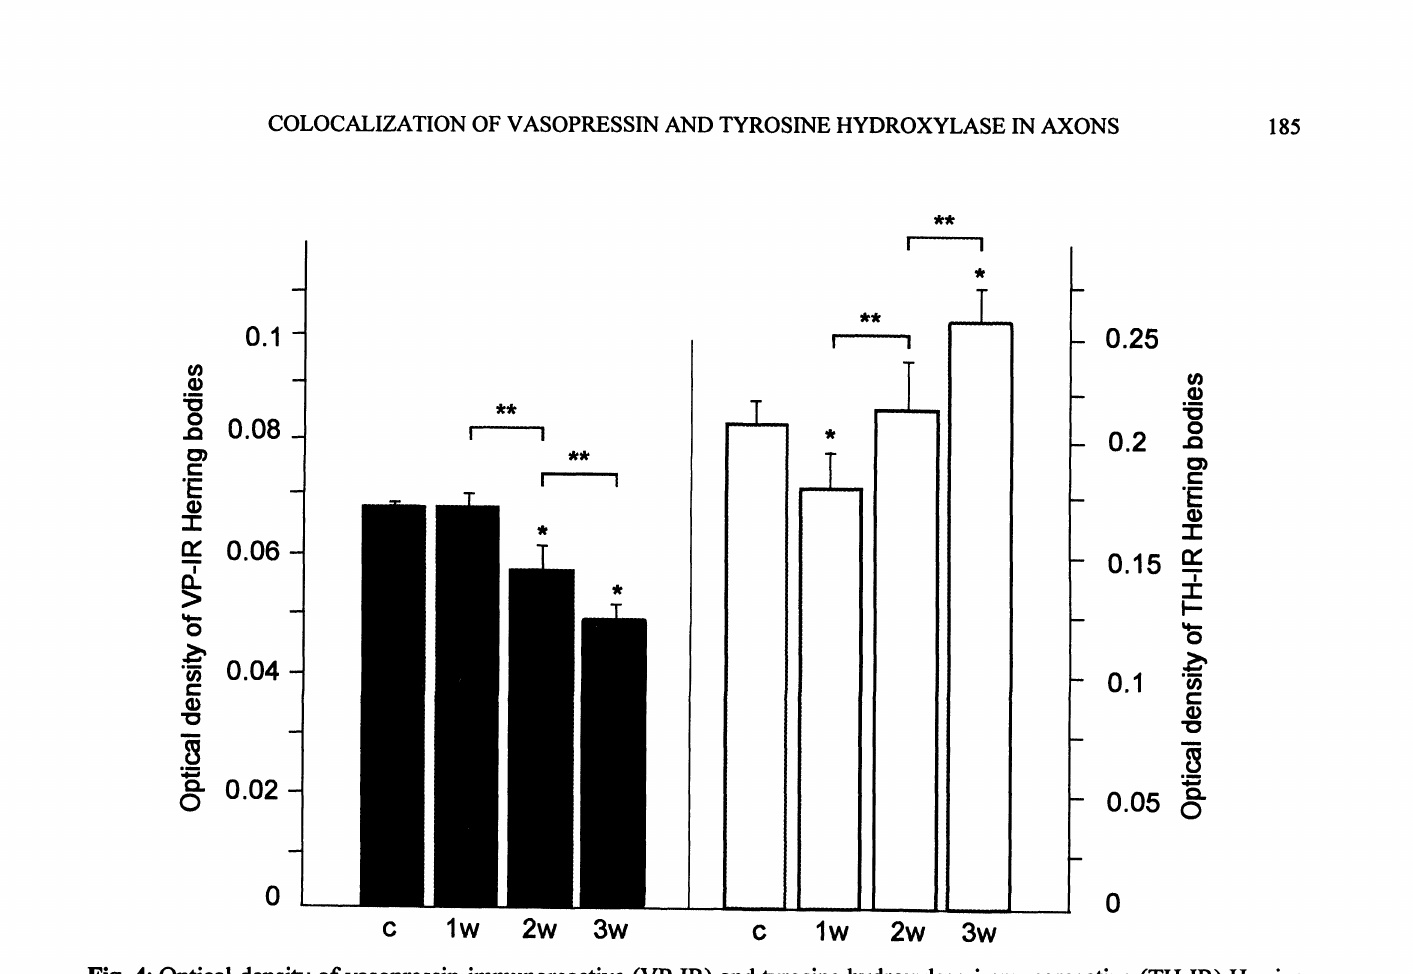
Fig. 4: Optical density of vasopressin-immunoreactive (VP-IR) and tyrosine hydroxylase-immunoreactive (TH-IR) Herring bodies in the posterior lobe in control (intact) rats (c) and in rats salt-loaded (2% NaCI) for 1, 2 and 3 weeks (w). * P < 0.01, compared to the control. ** P < 0.01, comparison between selected groups.